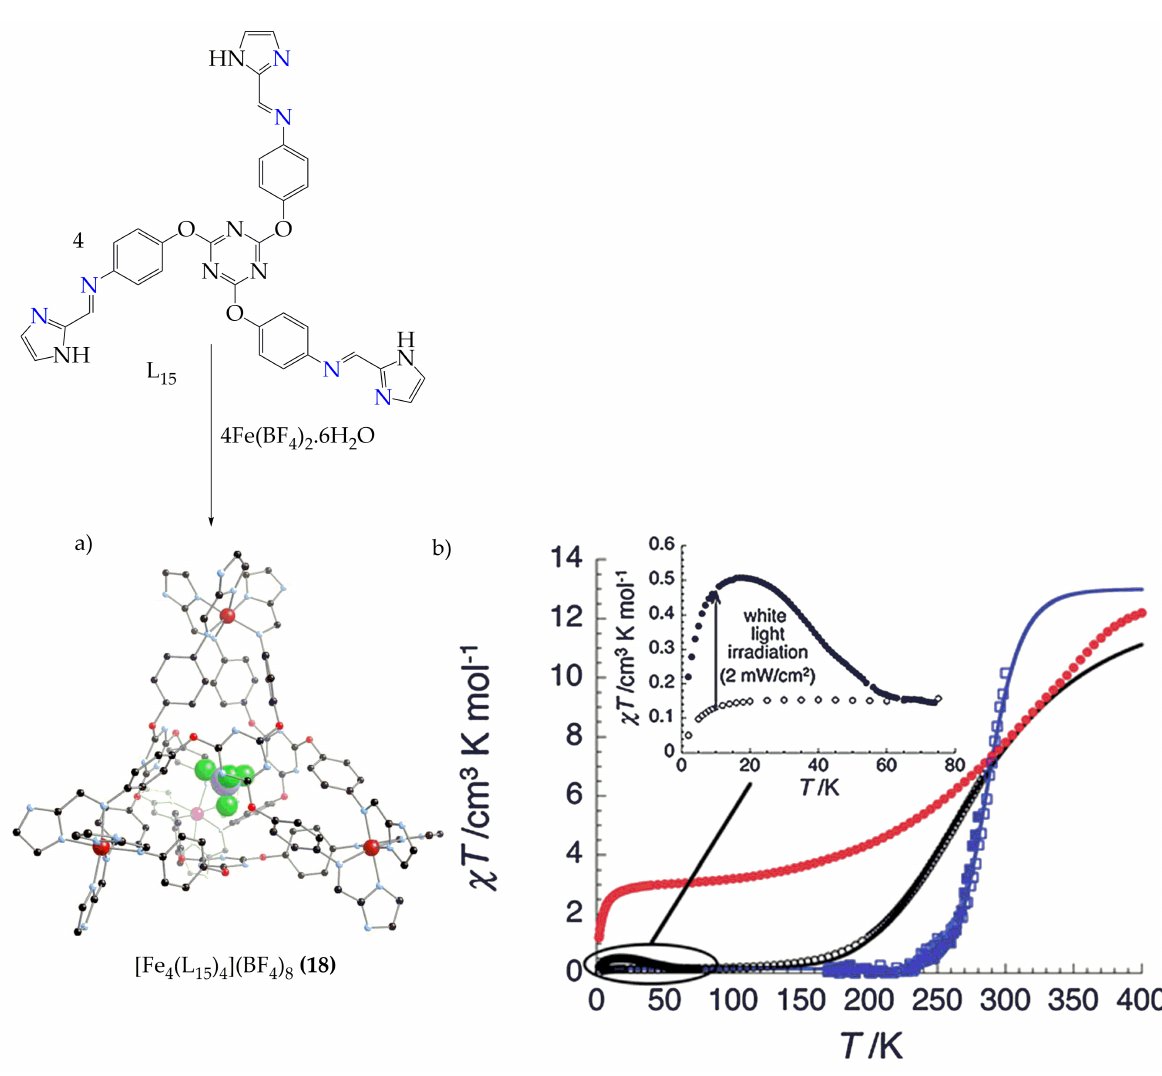
Figure 13. ( a ) Structure of complex 18 showing the encapsulated BF 4 counter anion in space fill; ( b ) χ T vs. T data of Complex 18. Reproduced from [96]; Published by Royal Society of Chemistry, 2013.